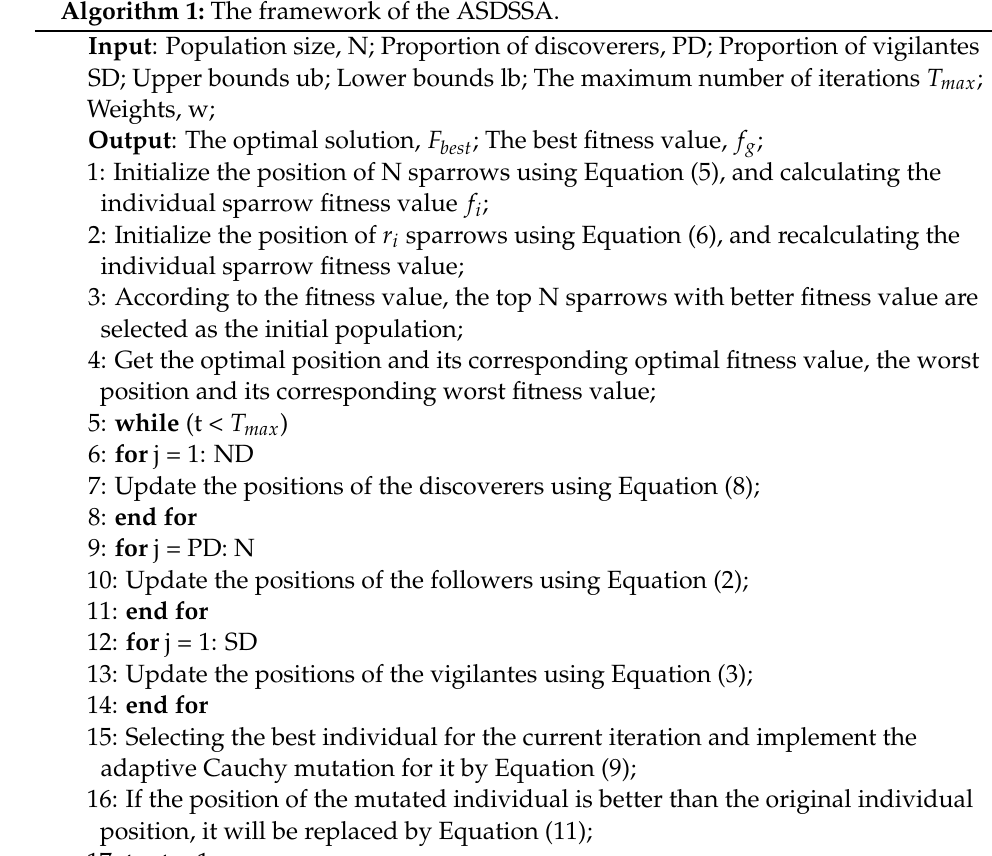
Algorithm 1: The framework of the ASDSSA.